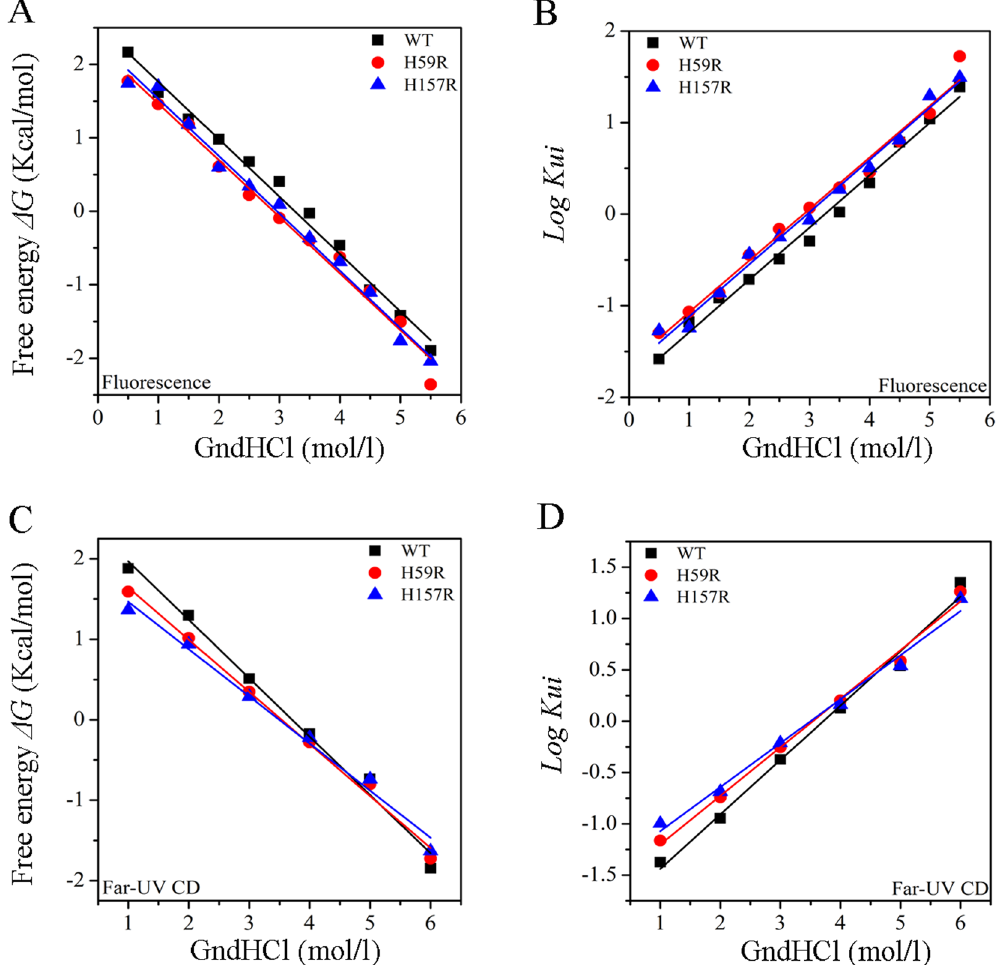
Figure 6. Chemical-induced conformational changes. ( A , B ) Represent free energy of unfolding ( Δ G 0 ) and unfolding kinetics rate constants ( log K ui ) against GdnHCl on the basis of fluorescence spectra, respectively. ( C , D ) Represent free energy of unfolding ( Δ G 0 ) and unfolding kinetics rate constants ( log K ui ) against GdnHCl on the basis of far-UV CD spectra, respectively. Intercepts at y axis give Δ G 0 and log K obs ,